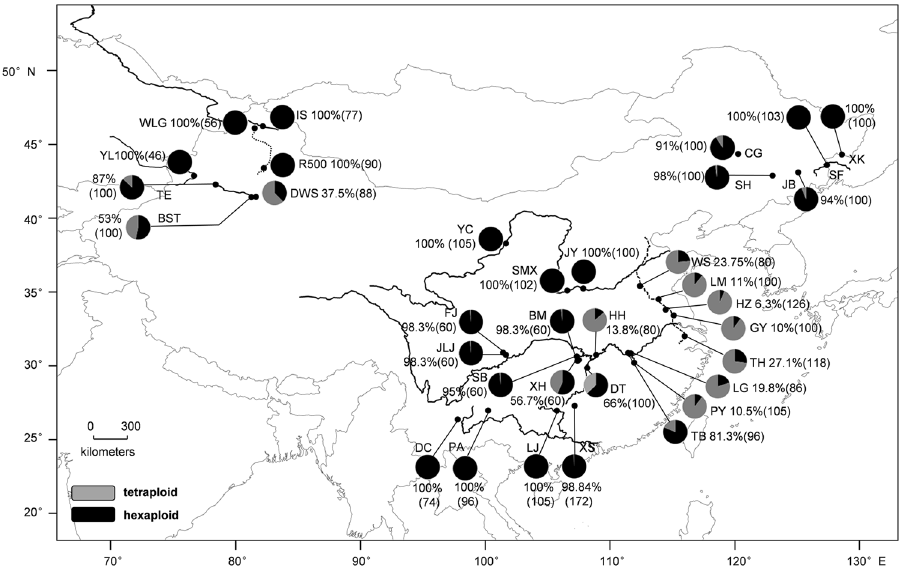
Figure 1. Geographical distribution of the 34 sampled populations. The detailed information of sampled sites is in Table S1. The proportions of hexaploids and tetraploids are indicated by the sizes of black and gray pie charts respectively. Percentage of hexaploids and sample size in bracket are given nearby. The map was created in ARCMAPv.9.3 (ESRI, Redlands, CA, USA)